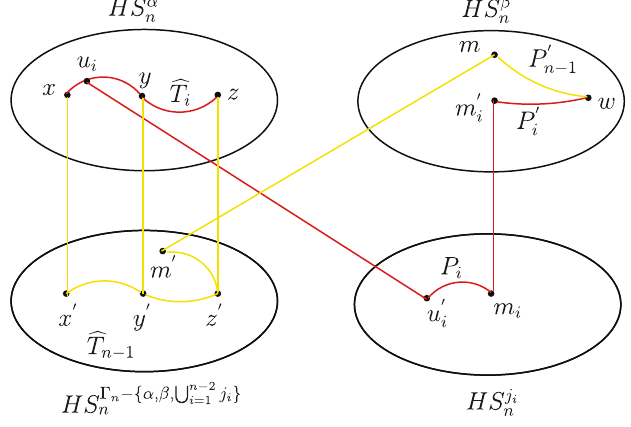
Figure 3: The illustration of Case